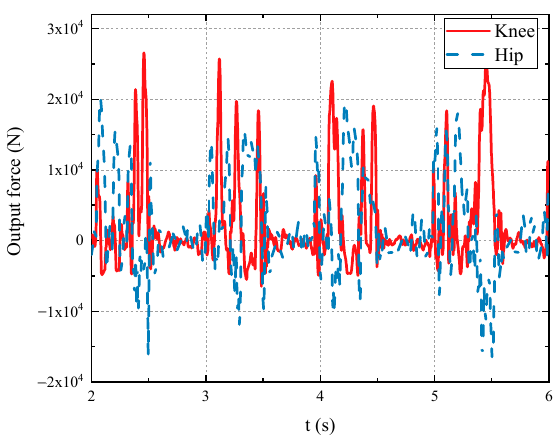
Figure 11. Hydraulic cylinder output force.